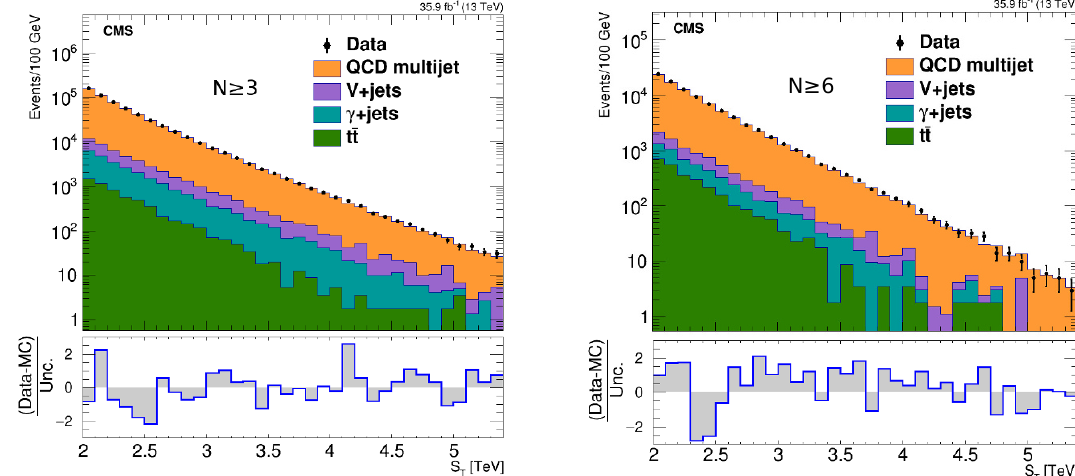
Figure 2 . The S T distribution in data for inclusive multiplicities of (left) N (cid:21) 3 and (right) N (cid:21) 6, compared with the normalized background prediction from simulation, illustrating the relative contributions of major backgrounds. The lower panels show the di(cid:11)erence between the data and the simulated background prediction, divided by the statistical uncertainty in data. We note that despite an overall agreement, we do not rely on simulation for obtaining the background